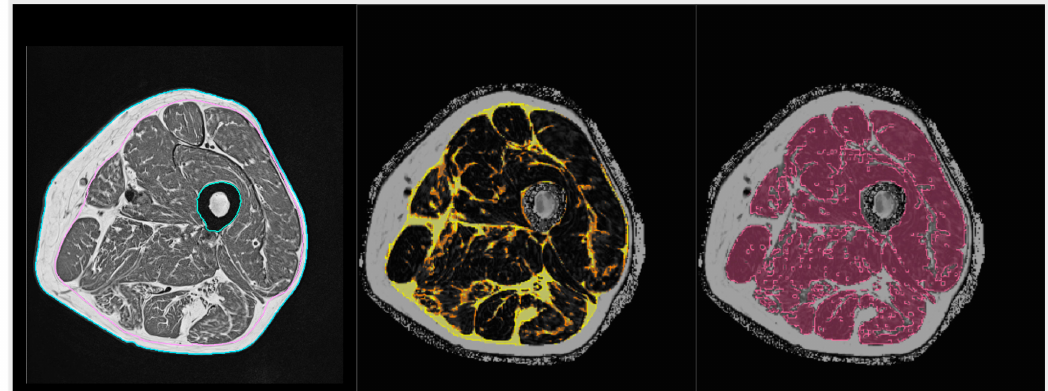
Figure 4. Segmentation of MRI (magnetic resonance imaging) images. left: T1 image used for the segmentation of the fascia lata (red) separating the subcutaneous adipose tissue from the group of muscles and IMAT; center: Dixon fat fraction (FF) image with segmented: muscles (black) and IMAT (yellow and red), smaller agglomerations of extramyocellular lipids (EMCL) are shown in red; right: remaining muscle tissue for which FF is determined (Images from University of